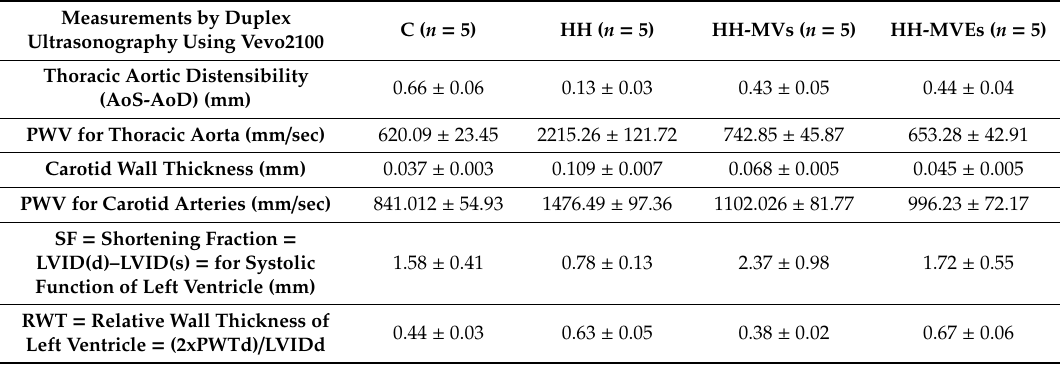
Table 4. Structural / architectural and flow changes of thoracic aorta, carotid artery and left ventricle as a measure of vascular rigidity and ventricular hypertrophy: diastolic diameter (AoD) and systolic diameter (AoS) of the ascending aorta or carotid artery, pulse wave velocity (PWV) for thoracic aorta and carotid artery, shortening fraction (SF) of left ventricle, diastolic diameter of left ventricle LVID(d), systolic diameter of left ventricle LVID(s), relative wall thickness of left ventricle (RWT), posterior wall thickness of left ventricle (PWTd). The data correspond to the analysis done at 4 months of diet and treatment.